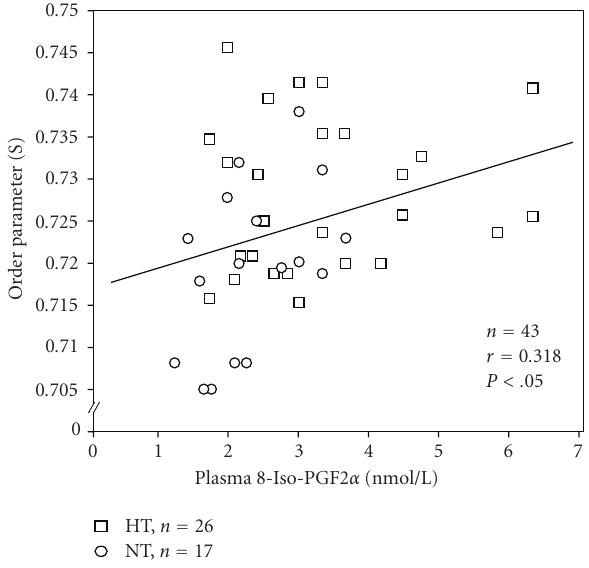
Figure 8: Correlation between plasma 8-iso-PG F2 α levels and the order parameter ( S ) of red blood cells (RBCs) in hypertensive and normotensive